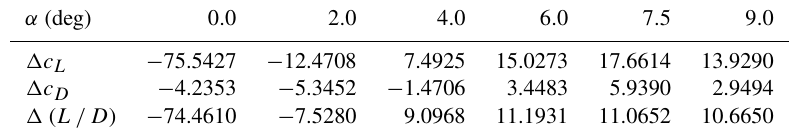
Table 6. Percentage change in aerodynamic characteristics of the membrane blade compared with the rigid blade. α (deg)